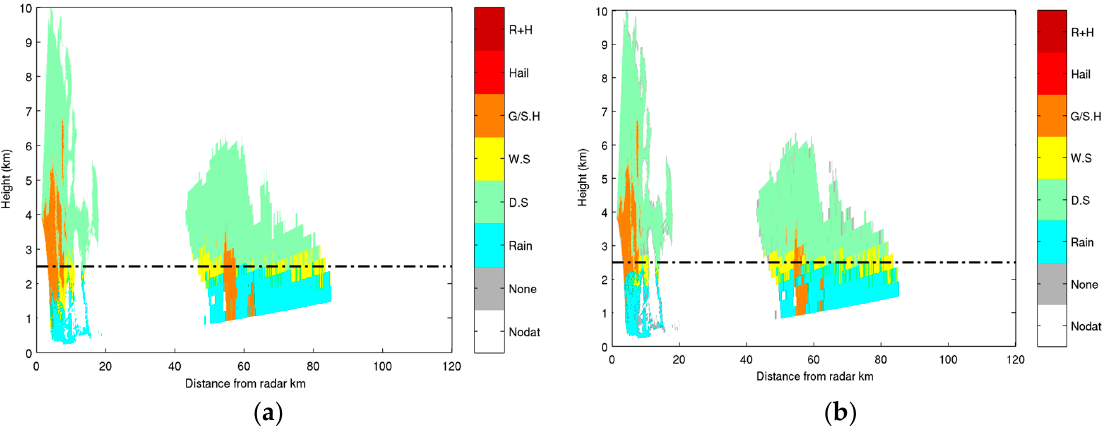
Figure 5. RHI sweep performed by Polar 55C on 15 October 2012 at 1738 UTC (293° azimuth) classified by SVM ( a ) and FL ( b ).